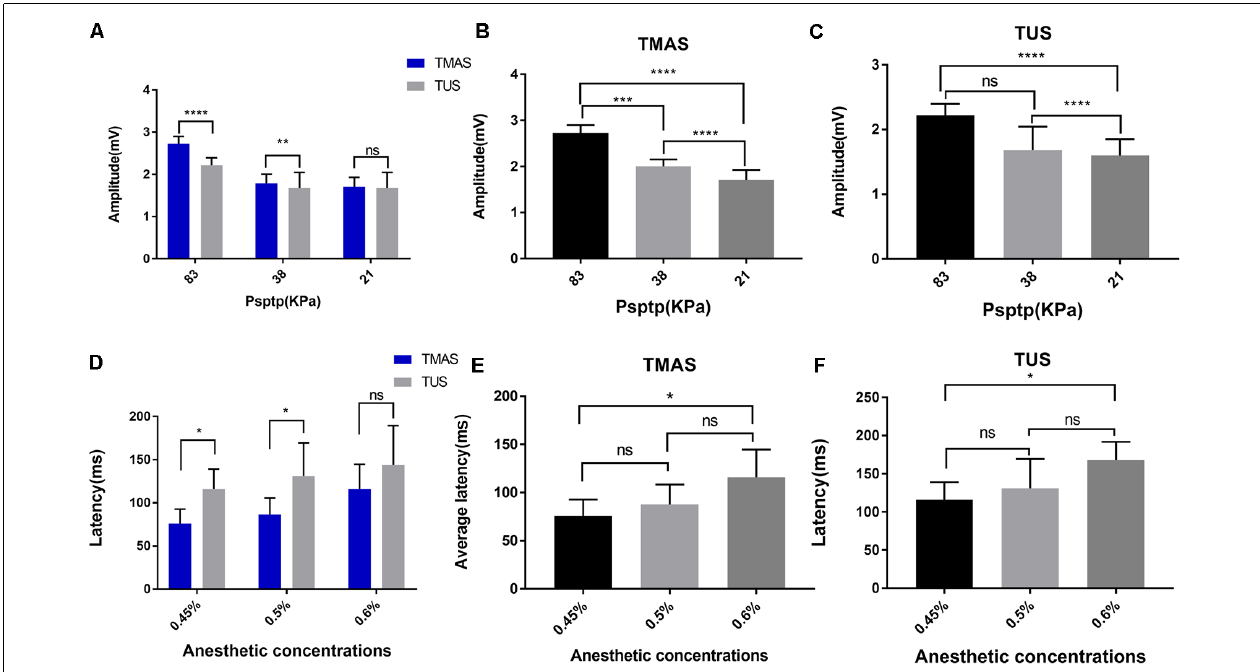
FIGURE 7 | EMG amplitude and response latency of TMAS and TUS at different Psptp and anesthetic concentrations. (A–C) EMG amplitude of TMAS and TUS at different Psptp. (A) The average amplitude of EMG induced by TMAS ( n = 8) and TUS ( n = 8) when the Psptp values were 83 KPa, 38 KPa, and 21 KPa. (B) Comparison of TMAS-induced EMG amplitudes when Psptp values were 83 KPa, 38 KPa, and 21 KPa. (C) Comparison of TUS-induced EMG amplitudes when Psptp values were 83 KPa, 38 KPa, and 21 KPa. (D–F) EMG response latency of TMAS and TUS at different anesthetic concentrations. (D) EMG average response latency induced by TMAS (blue histogram, n = 8) and TUS (gray histogram, n = 8) when the isoflurane gas anesthetic concentrations were 0.45%, 0.5%, and 0.6%. (E) Comparison of the average response latency of EMG induced by TMAS at anesthetic concentrations of 0.45%, 0.5%, and 0.6%. (F) Comparison of the average response latency of EMG induced by TUS at anesthetic concentrations of 0.45%, 0.5%, and 0.6% [ ∗ p < 0.05, ∗∗∗ p < 0.001, one-way analysis of variance (ANOVA), Bonferroni post-test]. ∗∗ p < 0.01, ∗∗∗∗ p < 0.0001, ns, means no statistical